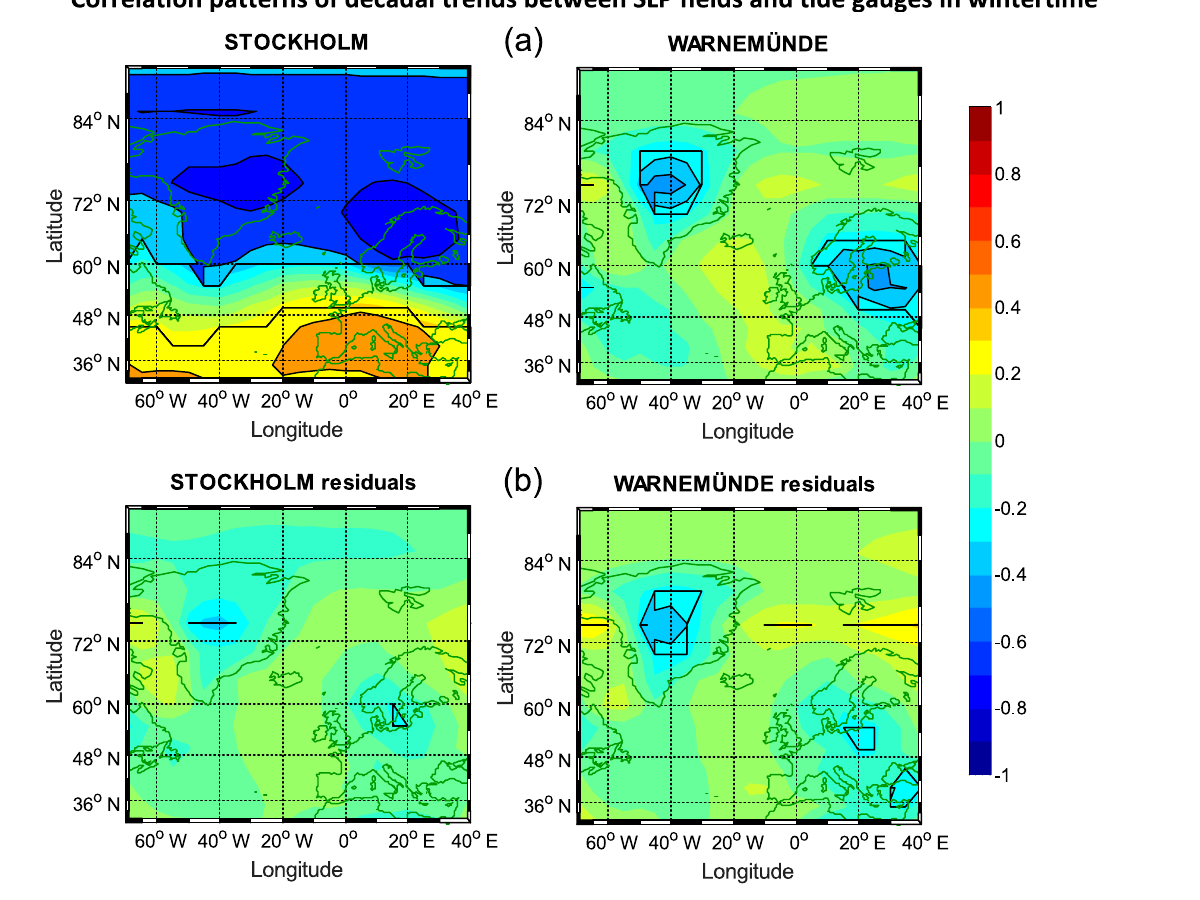
Figure 6. The correlation patterns between SLP fields and Stockholm and Warnemünde before (a) and after (b) removing the atmospheric signal in wintertime. The areas indicating significant correlations are delineated with contour lines. The 95% significance level is ± 0.19 for this record